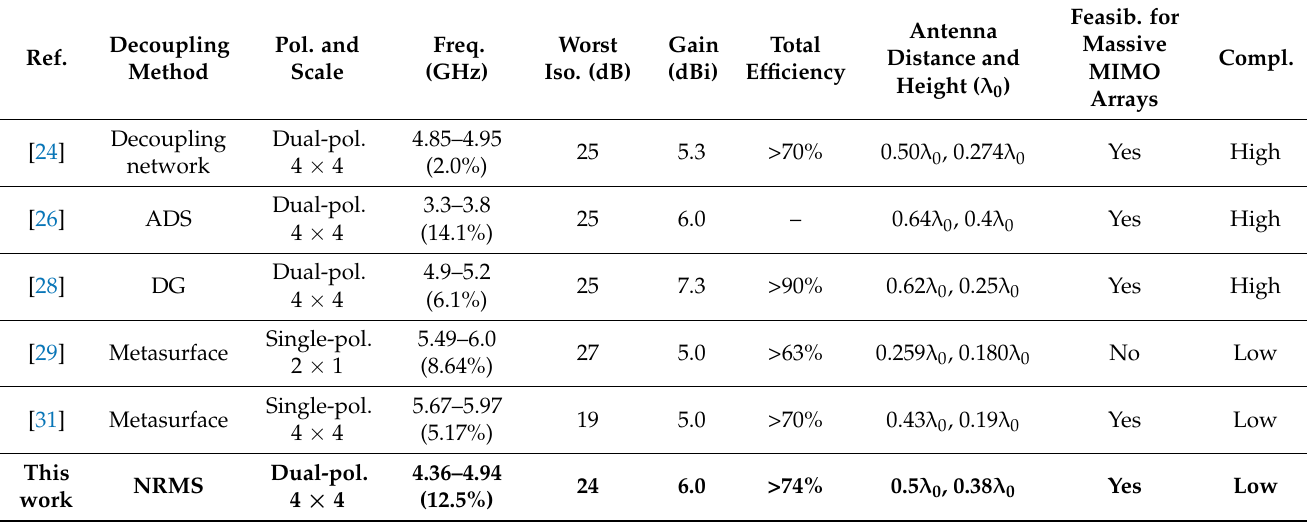
Table 2. Performance comparison of the proposed antenna arrays with other state-of-the-art similar